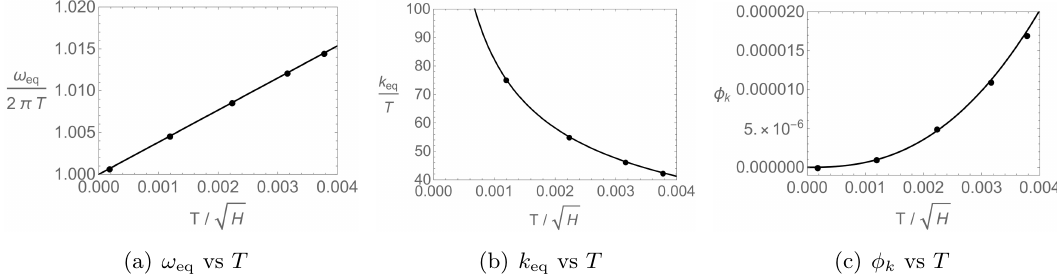
Figure 5 . The temperature dependence of ( ω eq , k eq , φ k ). Dots are numerical data and black solid lines are fitting curves